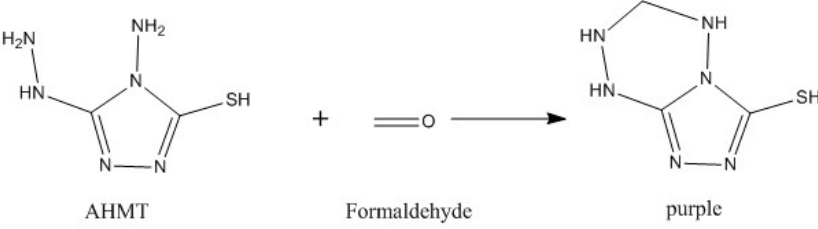
Figure 1. The principle of the AHMT method for detecting formaldehyde.